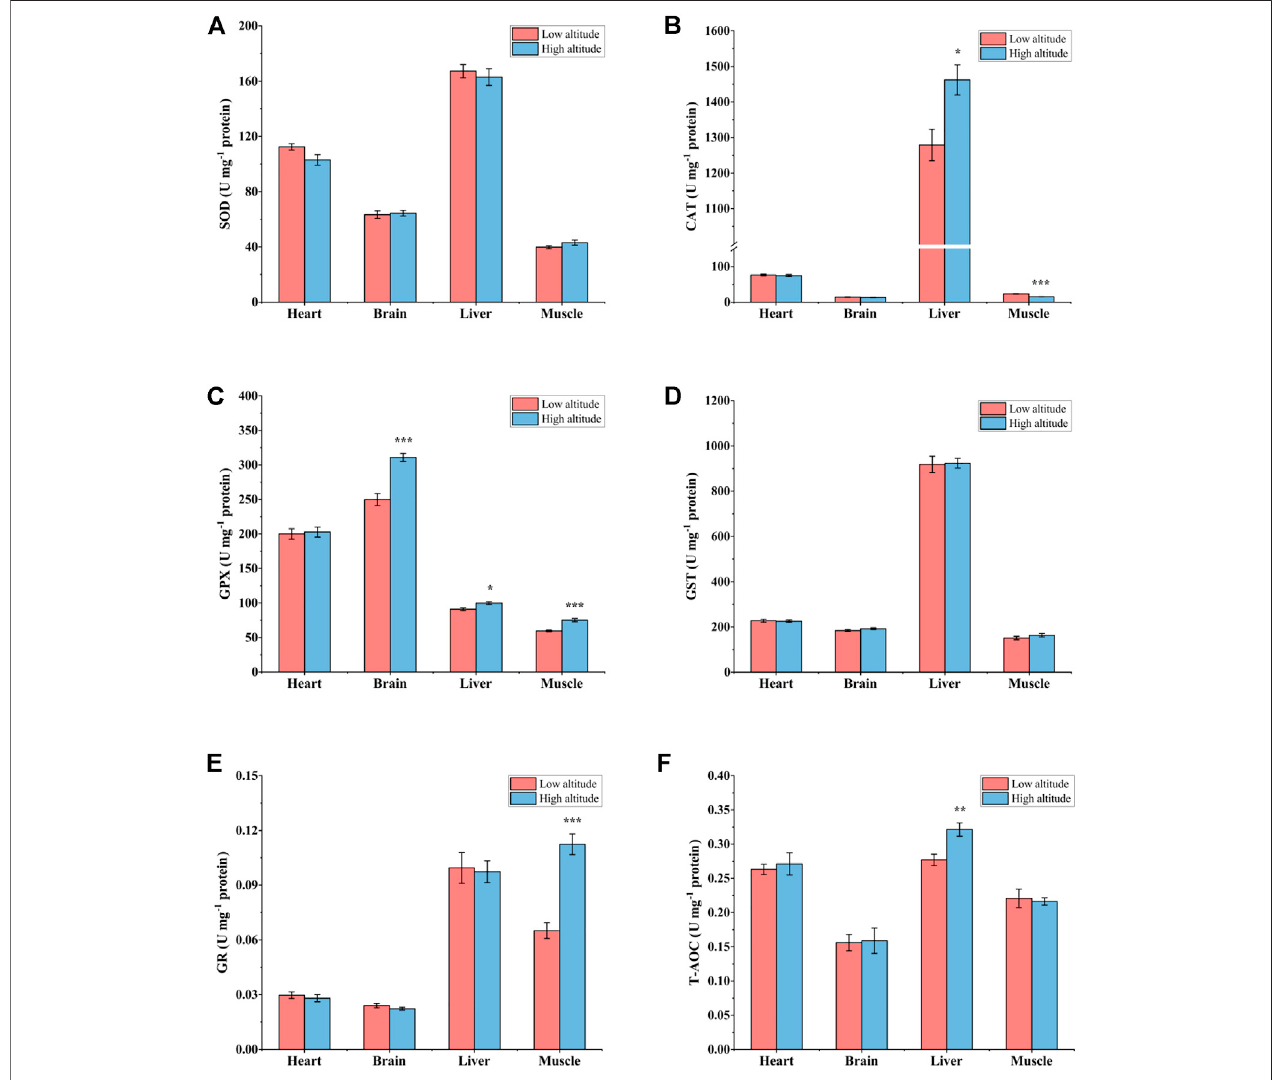
FIGURE 5 | Antioxidant enzyme activity and total antioxidant capacity (T-AOC) in heart, brain, liver, and muscle of low-altitude and high-altitude juvenile frogs. (A) superoxide dismutase (SOD) activity, (B) catalase (CAT) activity, (C) glutathione peroxidase (GPX) activity, (D) glutathione-S-transferase (GST) activity, (E) glutathione reductase (GR) activity and (F) total antioxidant capacity (T-AOC). Values are presented as mean ± SEM (n = 8). Asterisks (* p < 0.05; ** p < 0.01; *** p < 0.001) indicate signi fi cant difference between two populations.